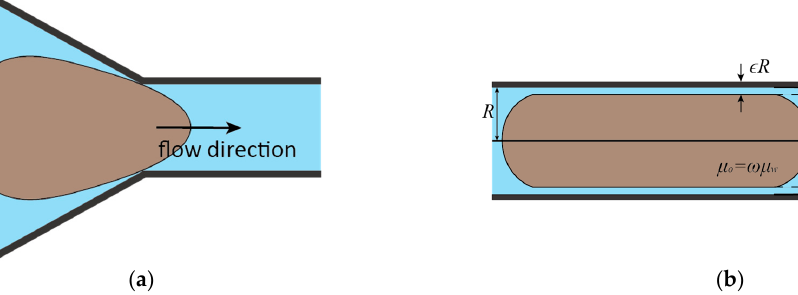
Figure 3. Schematic view of a deformed droplet with larger diameter than the capillary. ( a ) The schematic view of the droplet deforming to enter a smaller capillary; ( b ) the schematic view of the deformed droplet in the capillary.